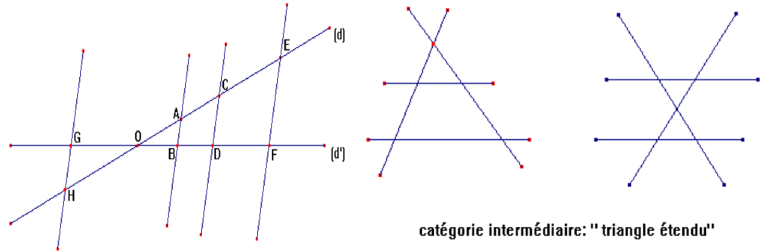
Fig. 4. Figure « parallèles et sécantes » et Figure « triangle étendu